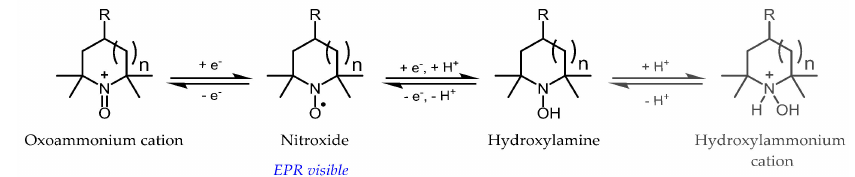
Figure 4. Redox reactions of nitroxides (pyrrolidine, n = 0; piperidine, n = 1); protonation of hydroxylamine to hydroxylammonium cation is also